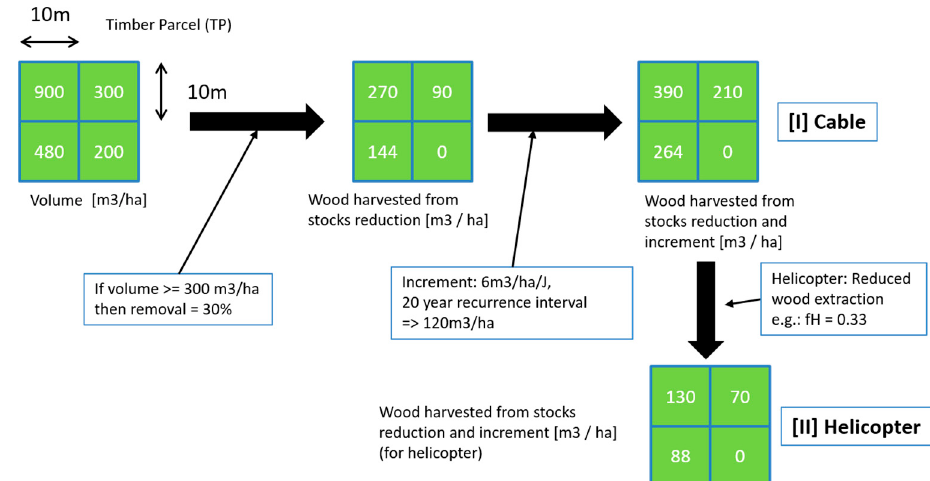
Figure 5. Estimation of the amount of wood to harvest for some exemplary chosen numbers for the volume map. Forests 2019 , 10 , 687